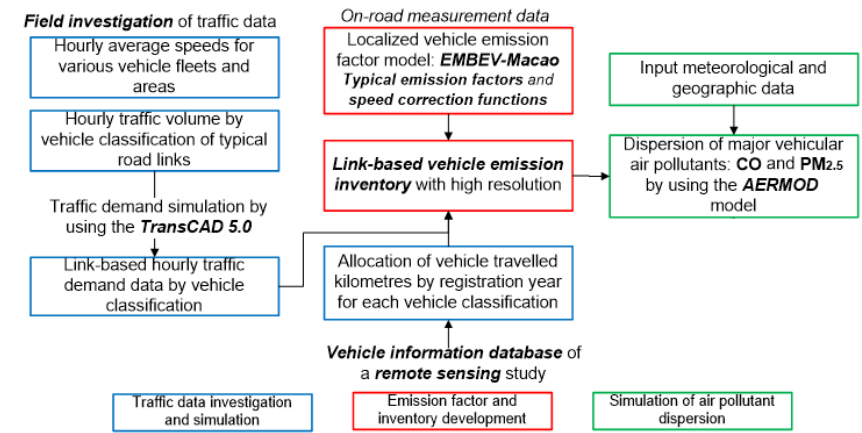
Figure 1. Framework of high-resolution simulation for vehicle emissions and concentrations of vehicular